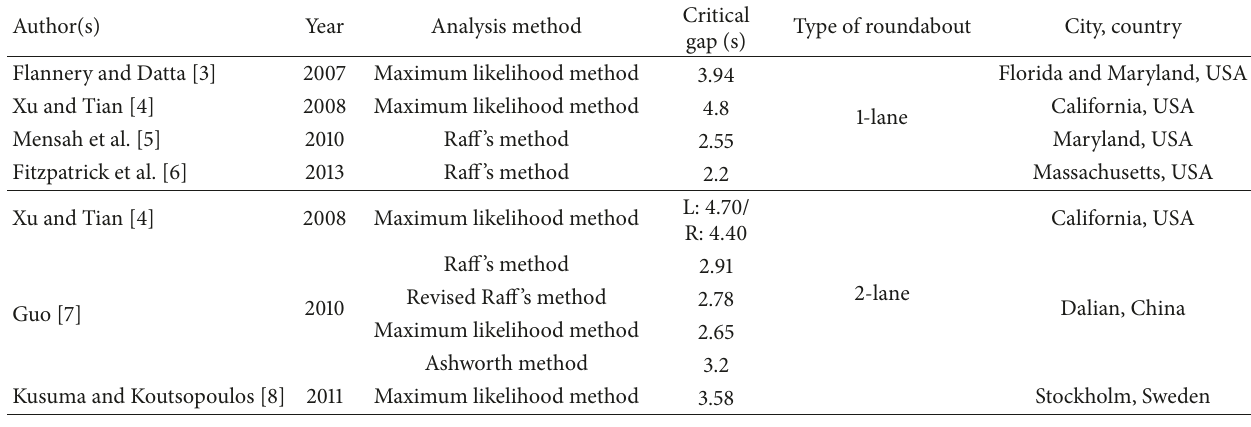
Table 1: Summary of past studies.